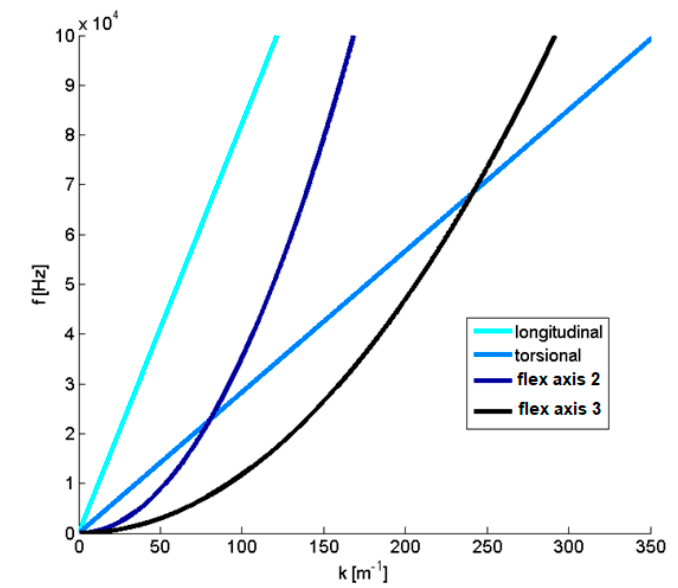
Figure 3. The dispersion curves computed by [11], for a waveguide of rectangular section 15 × 5 [mm]. Notice that in this graph the wave number is defined as k = 2 π / λ [m -1 ]. Table 1. Expressions of the dispersion curves considering the rod as a beam.